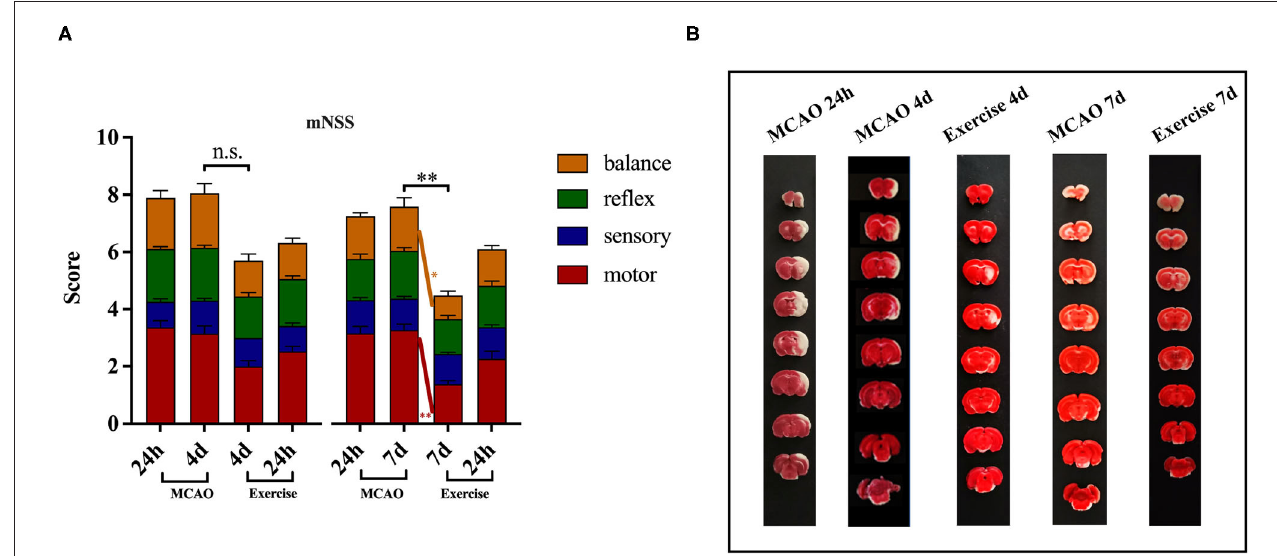
FIGURE 2 | Treadmill exercise alleviated neurological deficits and reduced infarct volume after MCAO. (A) Behavioral functions were assessed using mNSS in the MCAO and exercise groups 24h post-surgery before the animals were humanely killed (MCAO group: n = 19 for 4-day time points, n = 18 for 7-day time points; Exercise group: n = 20 for 4-day, n = 18 for 7-day time points). The data are presented as the mean ± SD. n.s.: p > 0.05, * P < 0.05, ** P < 0.01 vs. MCAO group. (B) Representative images of brain sections (8 consecutive sections at 2.0mm intervals from bregma) obtained after TTC staining from rats in the MCAO and exercise groups before they were humanely killed ( n = 1 per